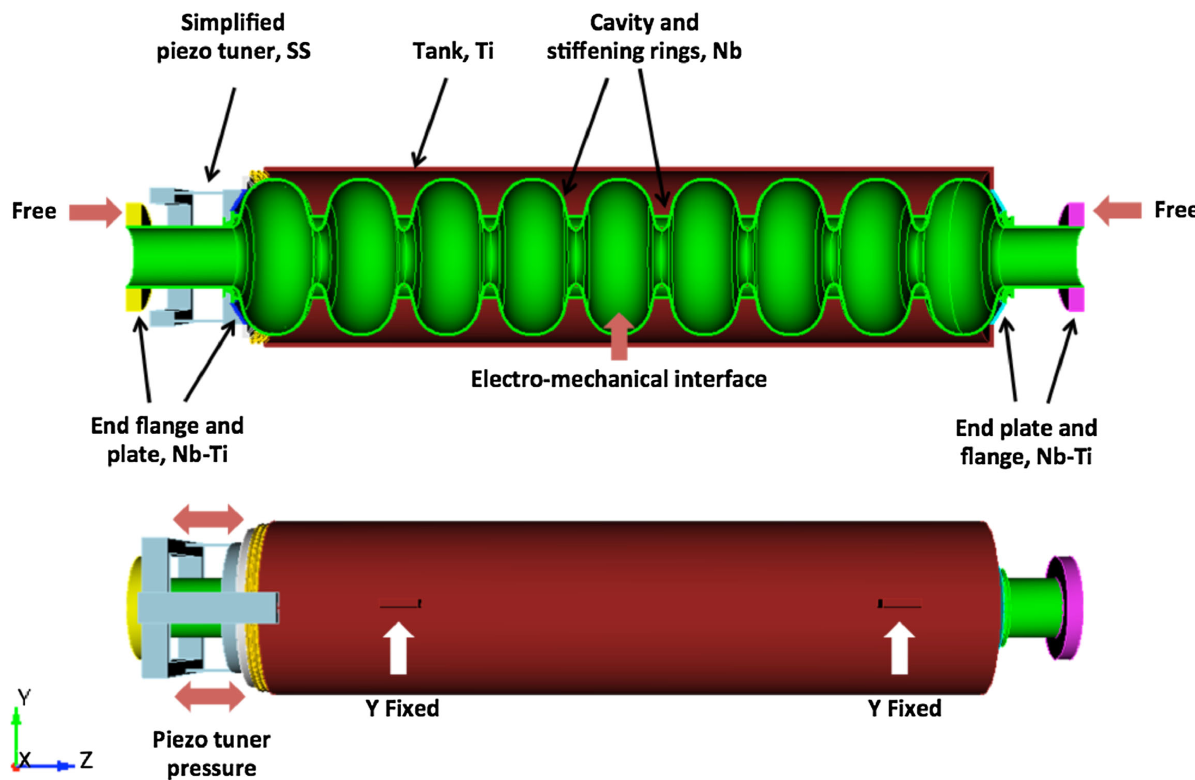
FIG. 2. The vertical cross section (top) and full (bottom) simulation model of the LCLS-II cavity including the electromechanical interface, boundary conditions, materials and the simplified piezotuner model.